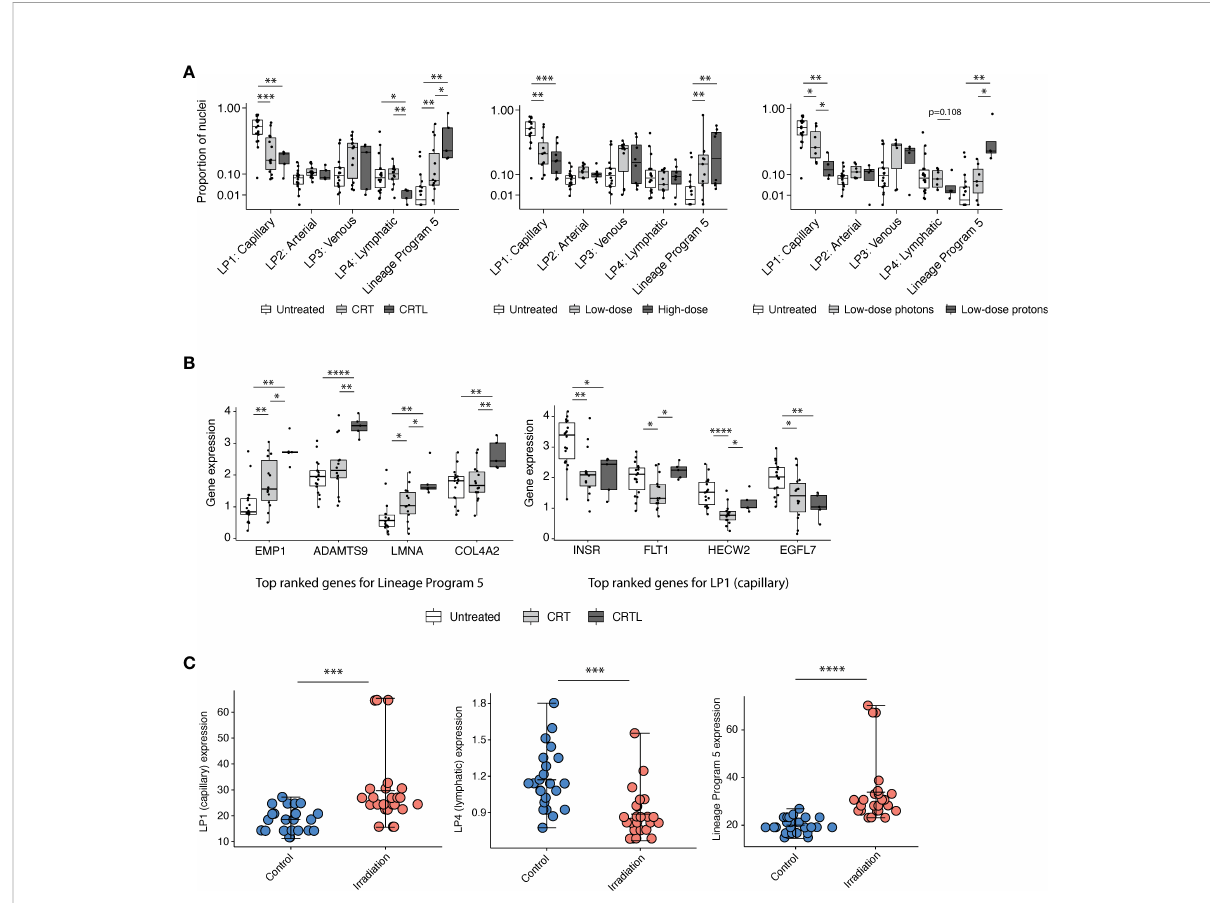
FIGURE 2 Capillary program depletion and reactive EndMT program enrichment in post-treatment residual human tumor specimens. (A) Proportion of endothelial nuclei for each of the fi ve lineage programs from PDAC tumors strati fi ed by treatment status (left; untreated, n = 18; CRT, n = 14; CRTL, n = 5), radiation dose (middle; untreated, n = 18; low-dose, n = 11; high-dose, n = 8), and radiation type (right; untreated, n = 18; low-dose photons, n = 7; low-dose protons, n = 4). * Benjamini – Hochberg-adjusted p value < 0.05, **p < 0.01, ***p < 0.001, FDR = 0.1, and two-sided Mann – Whitney U test. (B) Mean expression of top-ranked genes that characterize Lineage Program 5 (left) and Lineage Program 1 (capillary) (right) in endothelial nuclei across all PDAC samples, separated by treatment status (untreated, n = 18; CRT, n = 14; CRTL, n = 5). *Benjamini – Hochberg- adjusted p value < 0.05, **p < 0.01, ****p < 0.0001, FDR = 0.1, and two-sided Mann – Whitney U test. (C) Lineage Program 1 (capillary; Bonferroni- adjusted p value = 1.33 × 10 -4 ; two-sided Wilcoxon signed-rank test), Lineage Program 4 (lymphatic; p = 6.15 × 10 -4 ), and Lineage Program 5 (p = 6.79 × 10 -6 ) expression in non-irradiated versus irradiated primary human umbilical vein endothelial cells in vitro ( 8) (control, n = 24; irradiation, n = 24). Mean expression is denoted by the central hash and error bars extend from the minimum to maximum values for each condition. ***Bonferroni-adjusted p value <0.001, ****p < 0.0001, two-sided Wilcoxon signed-rank test. LP, Lineage